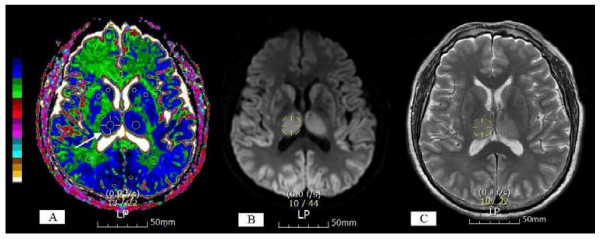
Apparent diffusion coefficient map with colour shades (A), diffusion-weighted imaging (B) and T2-weighted image (C) from one representative patient at seven hours after cardiac arrest. Regions of low apparent diffusion coefficient (ADC) showed a blue colour; in contrast, regions of high ADC showed a white colour. The colour shades on the ADC maps identified the pixel showing the minimum ADC value in each brain region. A 3D cursor (arrow) was used to select the predefined spot (right thalamus) simultaneously in the three different sequences, and it can be easy to mark the area with the minimum ADC on the ADC maps based on the T2-weighted image (T2WI) and diffusion-weighted imaging (DWI). The circular region-of-interest (ROI) cursors were positioned on the areas with the minimum ADC in each brain region. Severely restricted diffusion within the ROIs was shown in the caudate nucleus (0.238 × 10-3mm2/sec), putamen (0.299 × 10-3mm2/sec), thalamus (0.290 × 10-3mm2/sec), and occipital grey matter (0.184 × 10-3mm2/sec) but not in the occipital white matter (0.712 × 10-3mm2/sec).